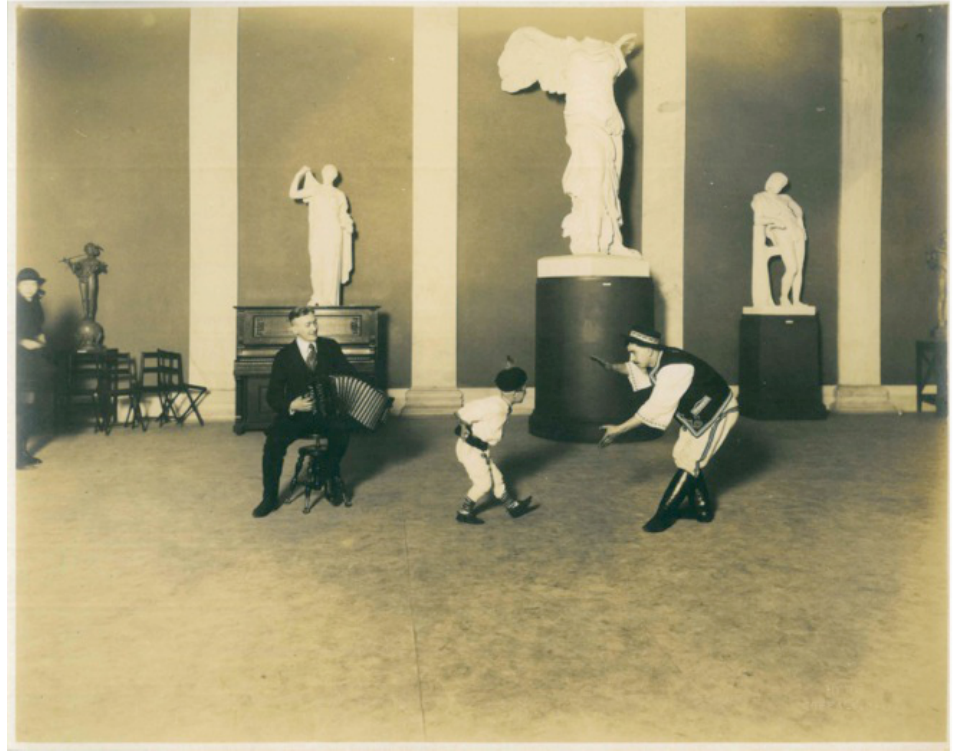
George Hare, Photograph of dancers performing during an event that corresponded with the Arts and Crafts of the Homelands exhibition held at the Albright-Knox Gallery October 22-November 4, 1919. © 2013 Albright Knox Gallery. Image courtesy of the G. Robert Strauss, Jr. Memorial Library, Gallery Archives, Albright Knox Gallery, Buffalo, New York